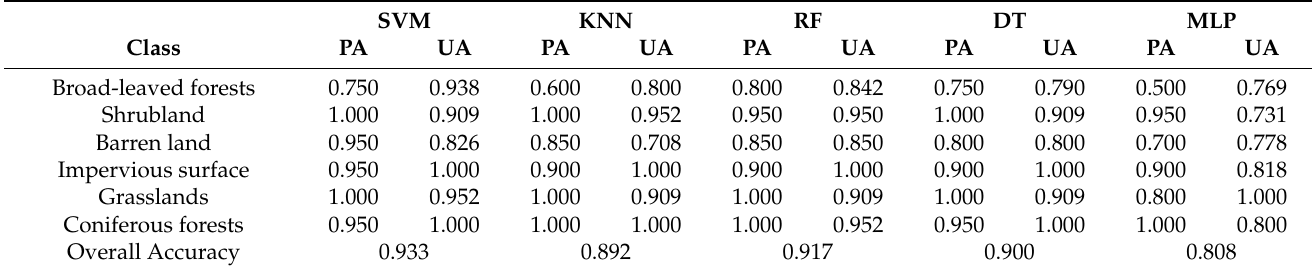
Table 4. Forest land resource information accuracy of five classifiers (SVM, KNN, RF, DT and MLP) based on Mul feature.